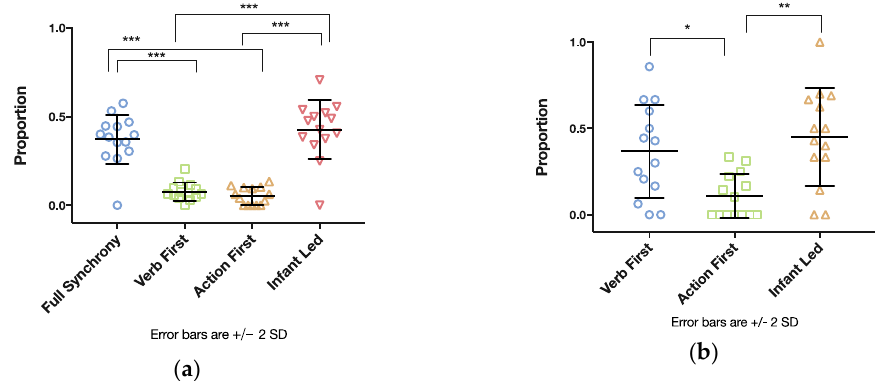
Figure 8. ( a ) Types of temporal coordination within a two-second time window. ( b ) Types of temporal coordination offset by more than 2 s (* p < 0.05; ** p < 0.01; *** p <